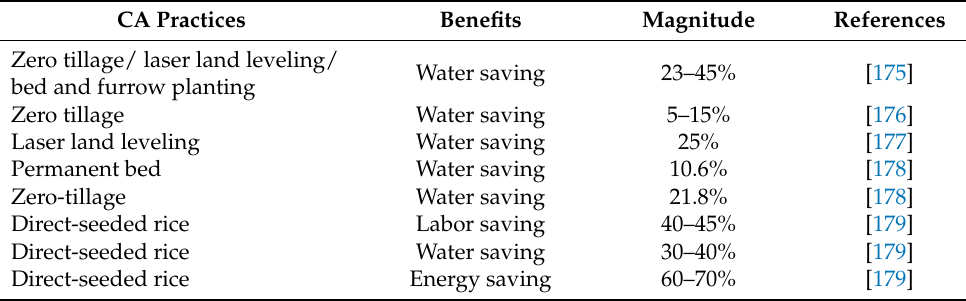
Table 2. Degree of benefits of conservation agricultural (CA)